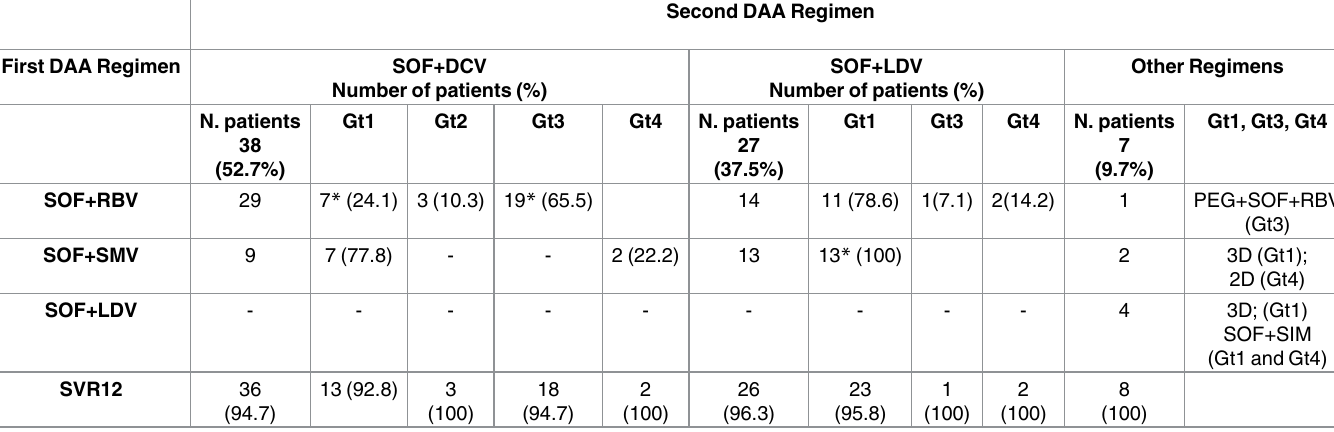
Table 4. Patients who receiveda second DAA treatment, by type of first regimen and HCV genotype (n = 72